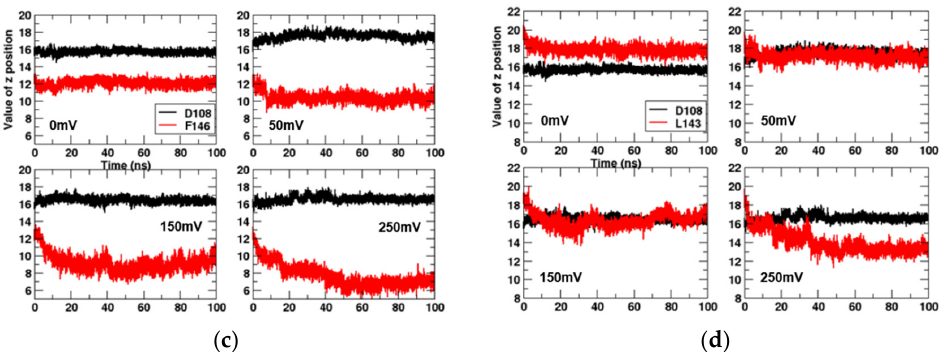
Figure 6. ( a , b ) Snapshots of a discontinuous water ‐ wire and a continuous water ‐ wire through the closed and open channel pores, respectively. The transmembrane part of the channel is represented by the purple ribbons, and the four residues of the gate are represented by the surface style (cyan: carbon; blue: nitrogen; and white: hydrogen). The oxygen atoms of water molecules in the channel pore are represented by red spheres. ( c ) The centers of sidechain of Asp108 and Phe146, and ( d ) Asp108 and Leu143 along the z ‐ axis are shown. The Z position was calculated after superimposing the channel using Asp108 residue as the reference.